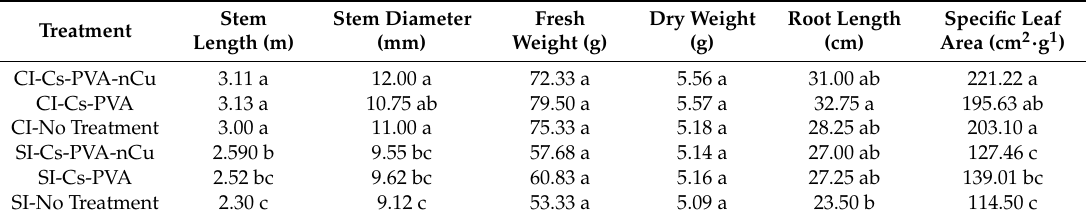
Table 5. Combined effect of grafting and application of gels on watermelon growth a biomass production. Treatment